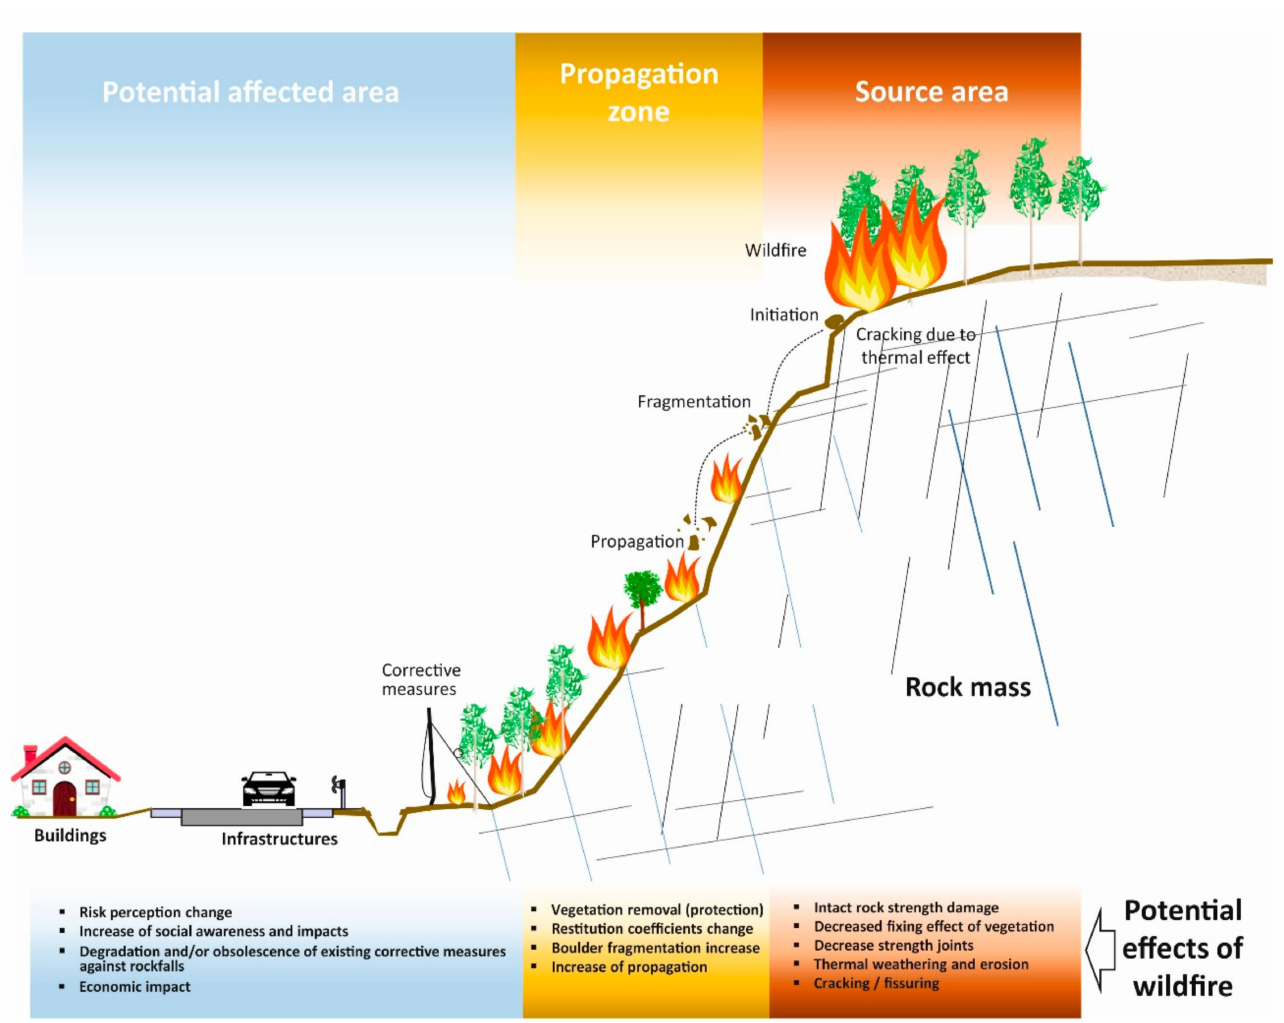
Figure 1. Diagram of potential wildfire effects on rockfall occurrence that frames the structure of this